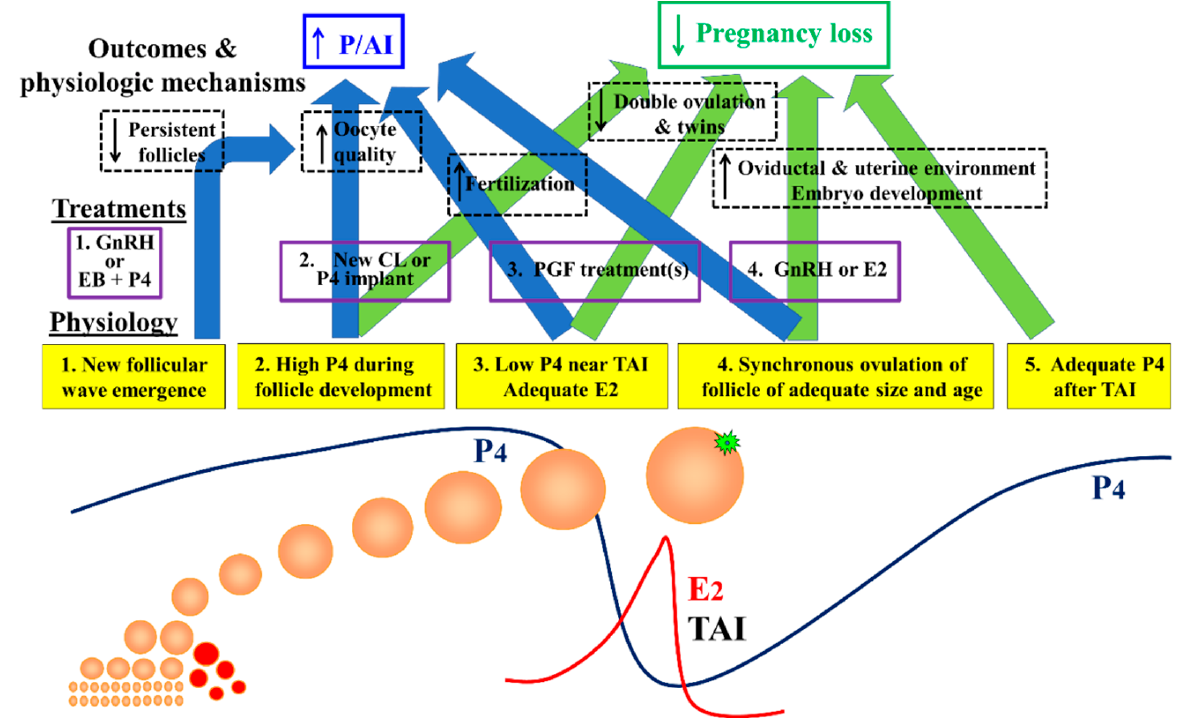
Figure 1. Key physiology (yellow rectangles) that should occur during timed artificial insemination (TAI) protocols in lactating dairy cows. Rectangles with purple lines show common treatments that are used to achieve these results and rectangles with dashed black lines show the mechanisms that produce increased pregnancy per artificial insemination (P/AI) or reduced pregnancy loss in TAI protocols. Corpus luteum (CL), estradiol (E2) benzoate (EB), gonadotropin-releasing hormone (GnRH), progesterone (P4), prostaglandin F2 α (PGF).